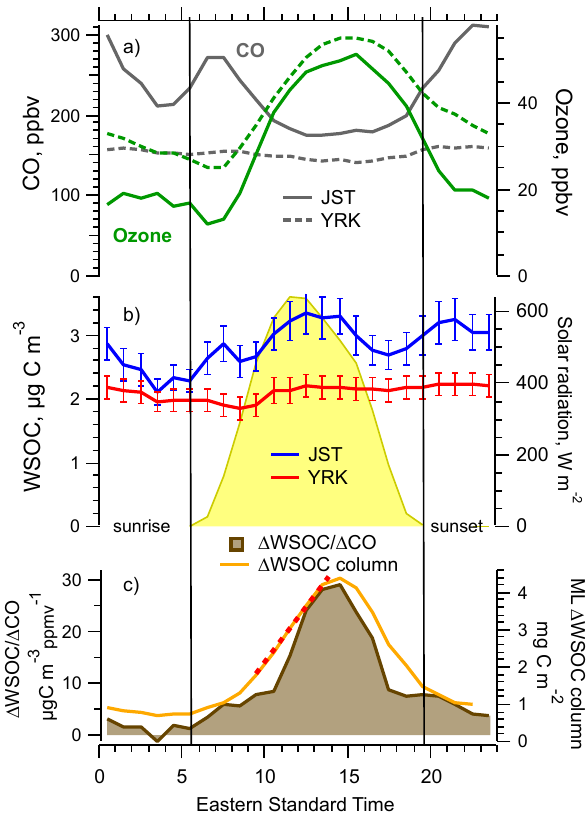
Fig. 9. Composite diurnal profiles of (a) CO, O 3 at JST and YRK, (b) WSOC concentrations at JST and YRK, solar intensity at JST, and (c) 1 WSOC/ 1 CO and mixed layer 1 WSOC column, where 1 WSOC/ 1 CO = WSOC (JST-YRK) /(CO – 0.15ppmv), and mixed layer 1 WSOC column = WSOC (JST-YRK) ×MLH (mixed layer height), during the AMIGAS sampling period. The red dotted line in panel (c) represents an estimate of urban WSOC production rate in unit of mgC m − 2 h − 1